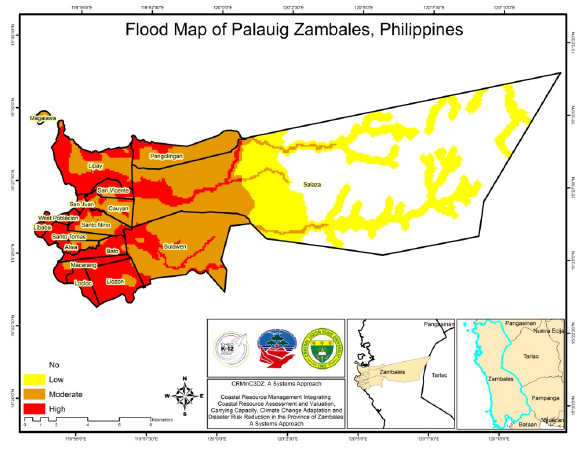
Figure 12. Flood hazard susceptibility of Palauig,